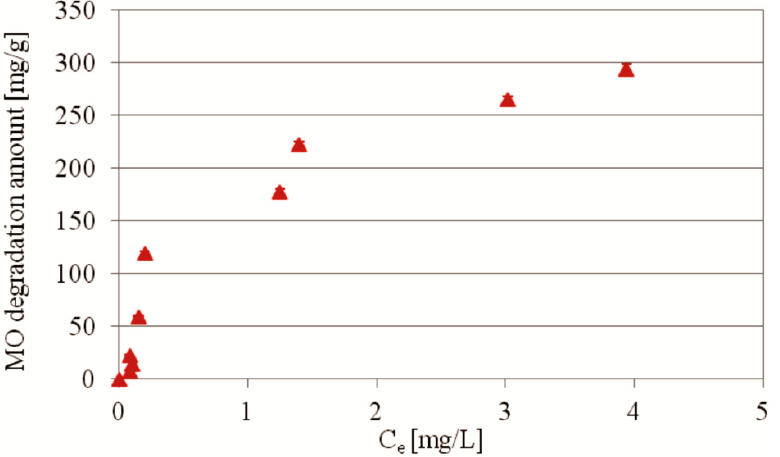
Figure 7. Isotherm of MO photocatalytic degradation as a function of the initial concentration of MO in the presence of PdCl2 biosilica photocatalyst. Experimental conditions: m (biosilica)—10 mg; t = 75 min; T = 25 °C; C 0 (MO)—5–200 mg/L; V (MO solution)—15 mL; pH—7.0.